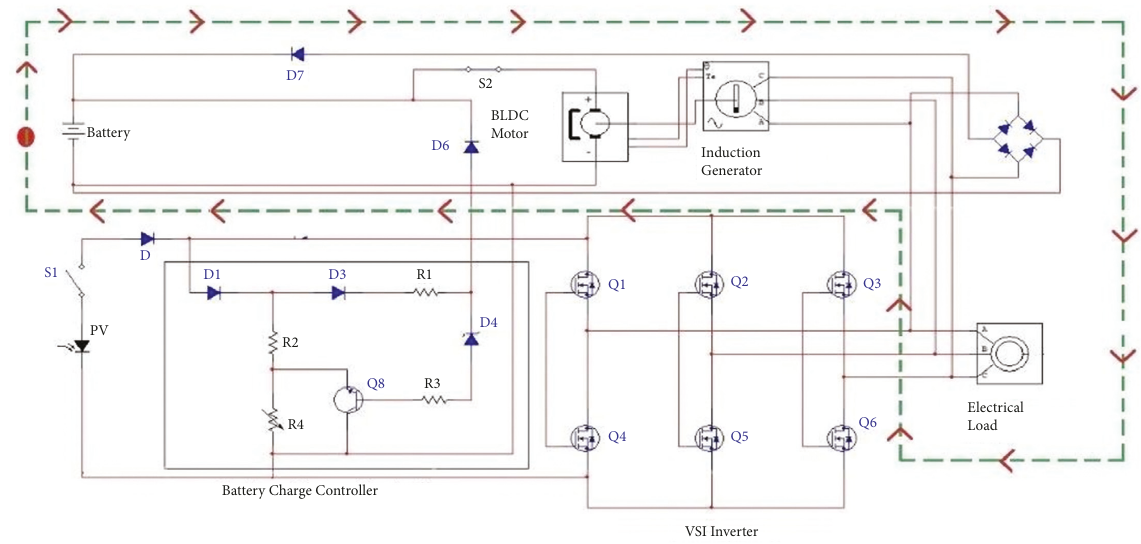
Figure 7: Battery to the electrical